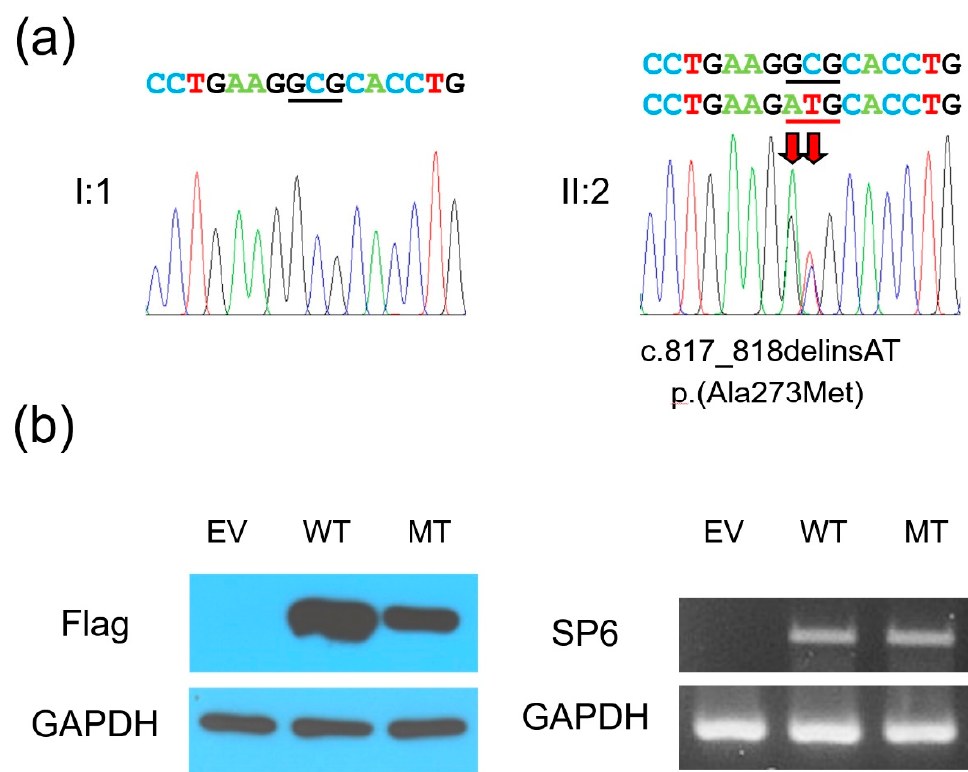
Figure 3. ( a ) DNA sequencing chromatograms of the PCR amplification products from the father (I:1) and the proband (II:2). The wild-type (top) and the mutated nucleotide sequences (bottom) are shown above the chromatograms. Red arrows indicate the location of the mutation [c.817_818delinsAT, p.(Ala273Met)]. Nucleotides encoding the amino acid at codon position 273 are underlined with black (wild-type allele) and red (mutant allele) lines. ( b ) Western blot and RT-PCR results. The C-terminal flag-tagged wild-type and the mutant human SP6 genes in the pcDNA3.1 vectors were transfected into COS-7 cells. After 30 hours, the cells were harvested for protein and total RNA collections. Western blot using flag antibody showed weak expression of mutant SP6 protein (left images), but the mRNA expression level was similar between the wild-type and mutant form (right images). EV: empty vector, WT: wild-type, MT: mutant. Table 1. Statistics for whole exome sequencing. Sample